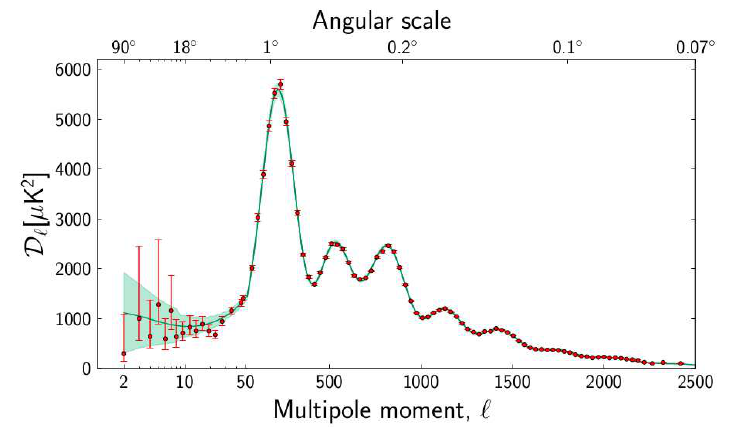
Figure 2: CMB temperature angular power spectrum from Planck . The shaded area represents cosmic variance. The solid line corresponds to the best-fit six-parameter ΛCDM model quoted in the text. Figure taken from Planck Collaboration I